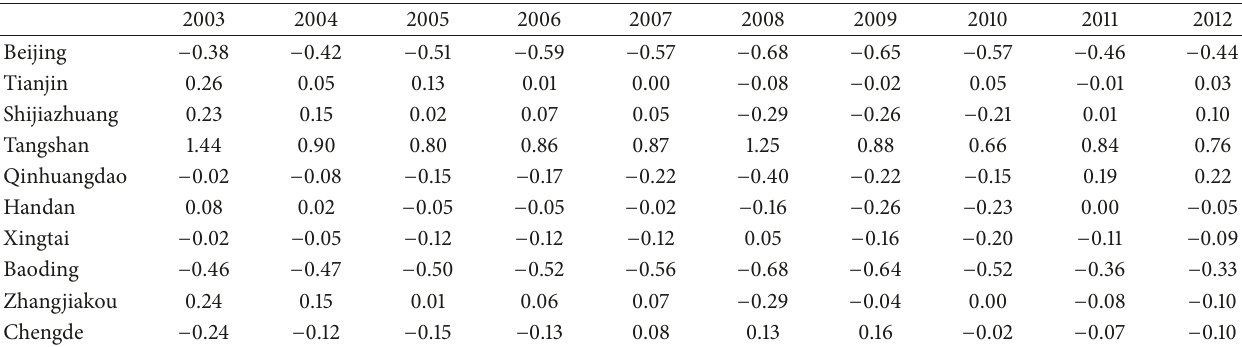
Table 1: The environmental pollution index of ten cities.